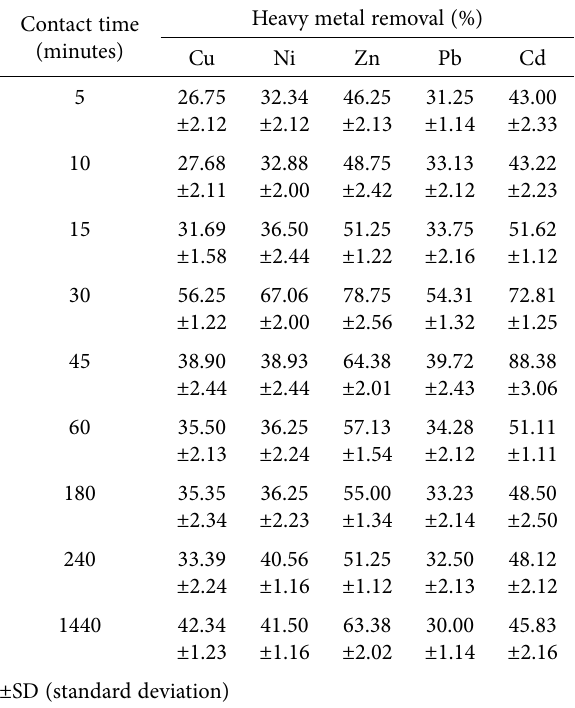
Table 5. Extraction efficiencies at different contact times using non-diluted molasses Hydrolysate (%) (mcompost = 5 g; Vsolution = 30 mL; pH ≤ 1, for each contact time n = 3)